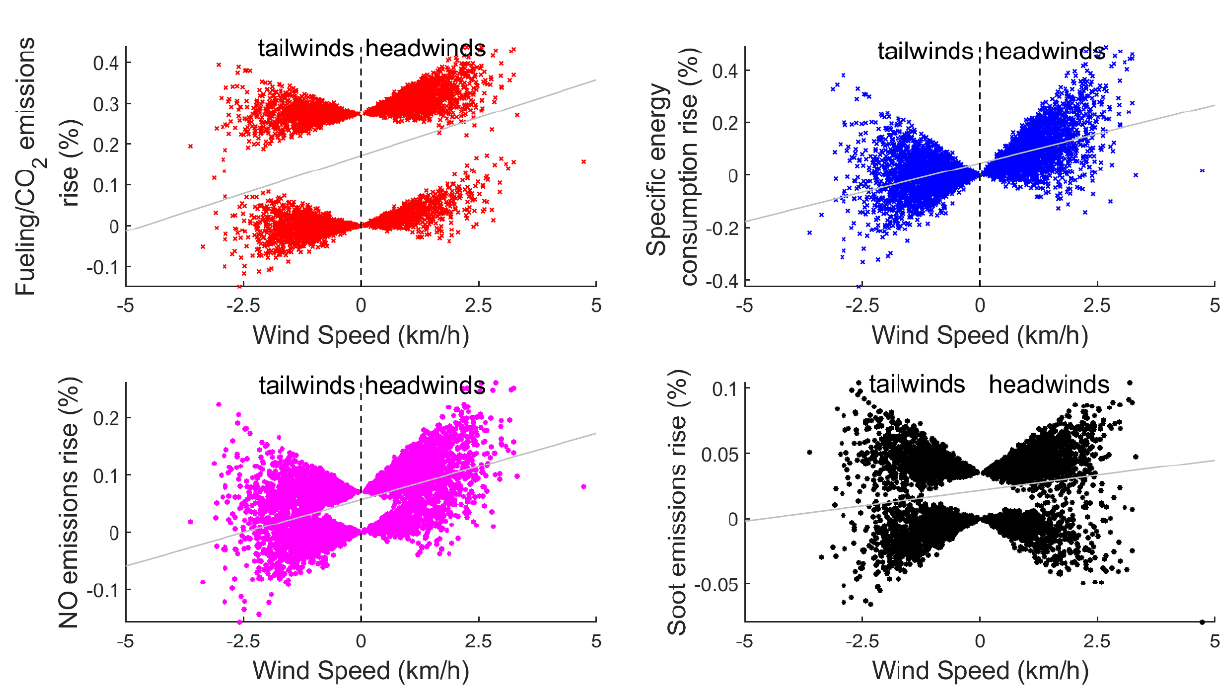
Figure 10. Percentage increase in consumption and emissions vs. wind speed for the low phase of the WLTC.